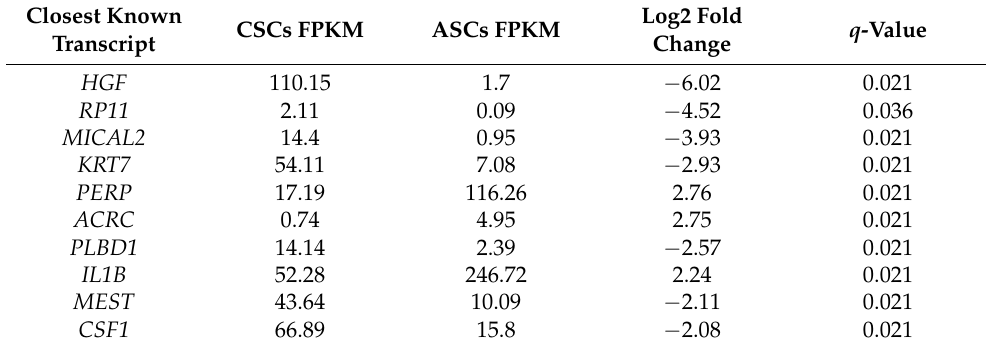
Table 3. Top 10 most significantly differentially expressed novel isoforms.